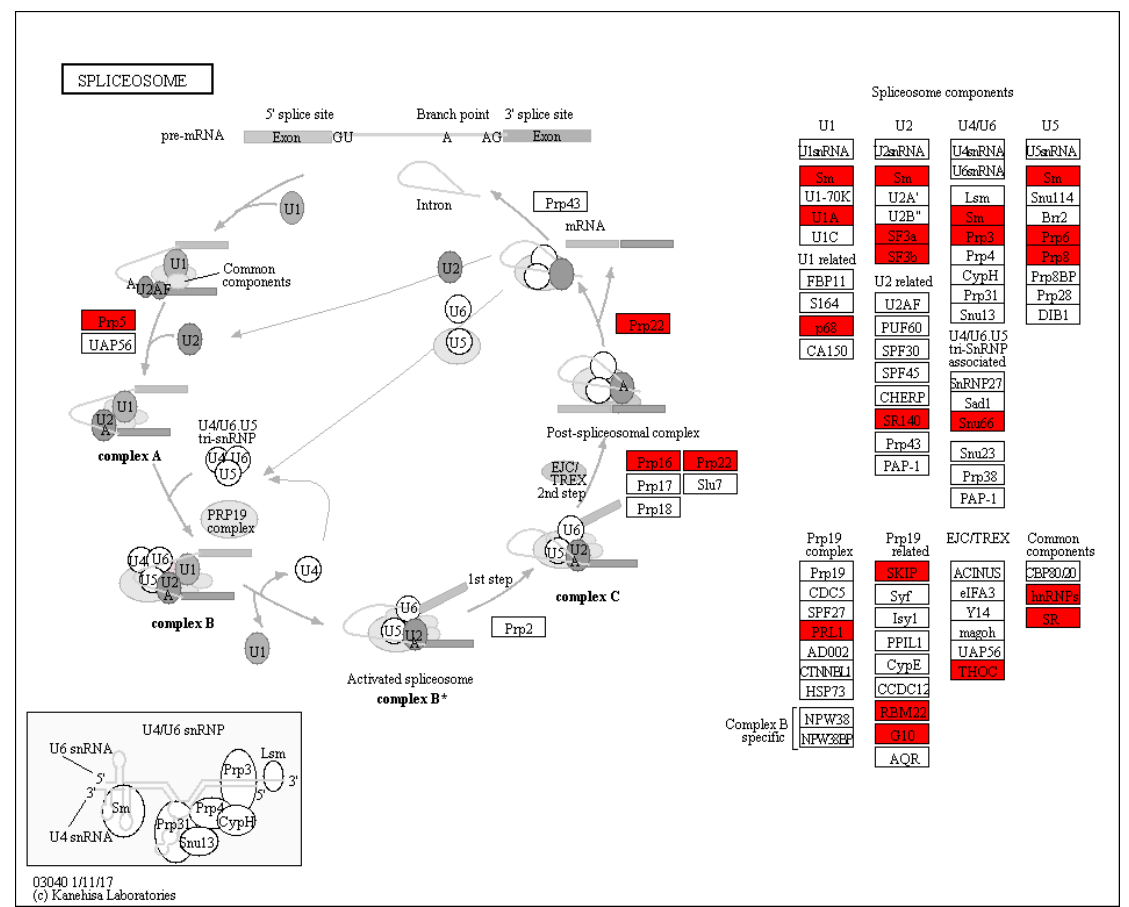
Figure 6. KEGG Pathway analysis of splicesome 75 h after self- and cross-pollination in C. oleifera . The red color indicated increased protein abundances level in self-pollinated pistils compared with cross-pollinated pistils.